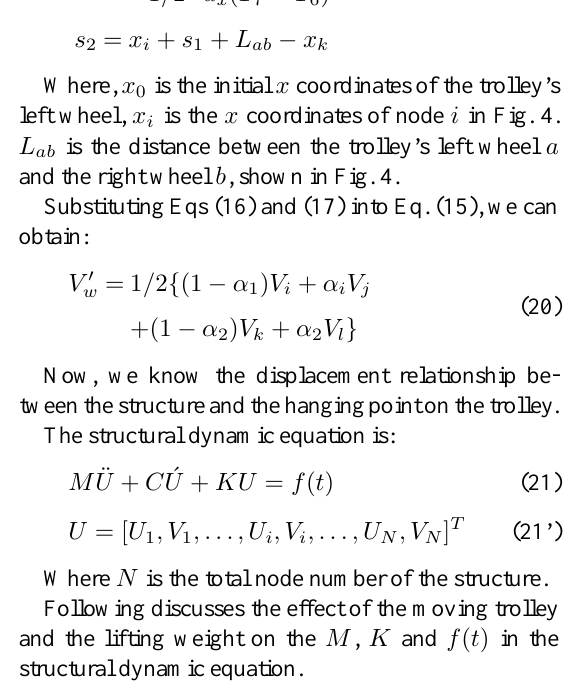
Fig. 4. Trolley move.